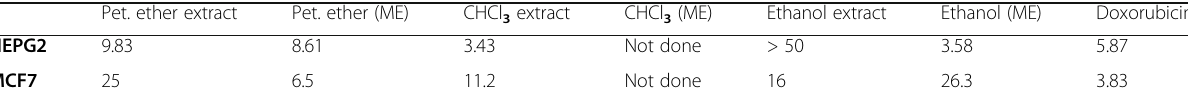
Table 5 IC 50 ( μ g/ml) of T. peruviana against liver and breast carcinoma cell lines Pet. ether